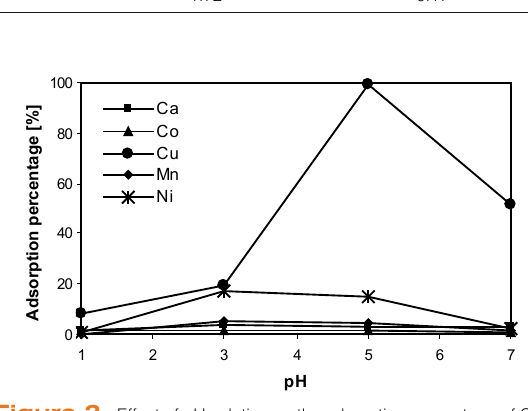
Figure 2. Effect of pH of solution on the percentage adsorption of Ca, Co, Cu, Mn, Ni ions by the support 1 .